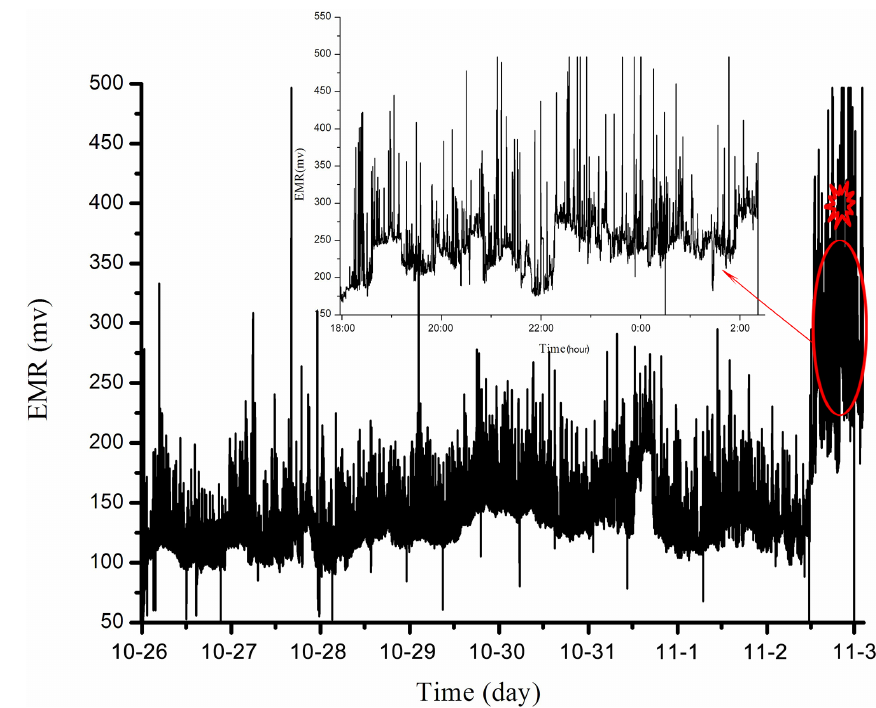
Figure 6. Dynamic variation of EMR generated from the coal rock of the bolted coal roadway in October